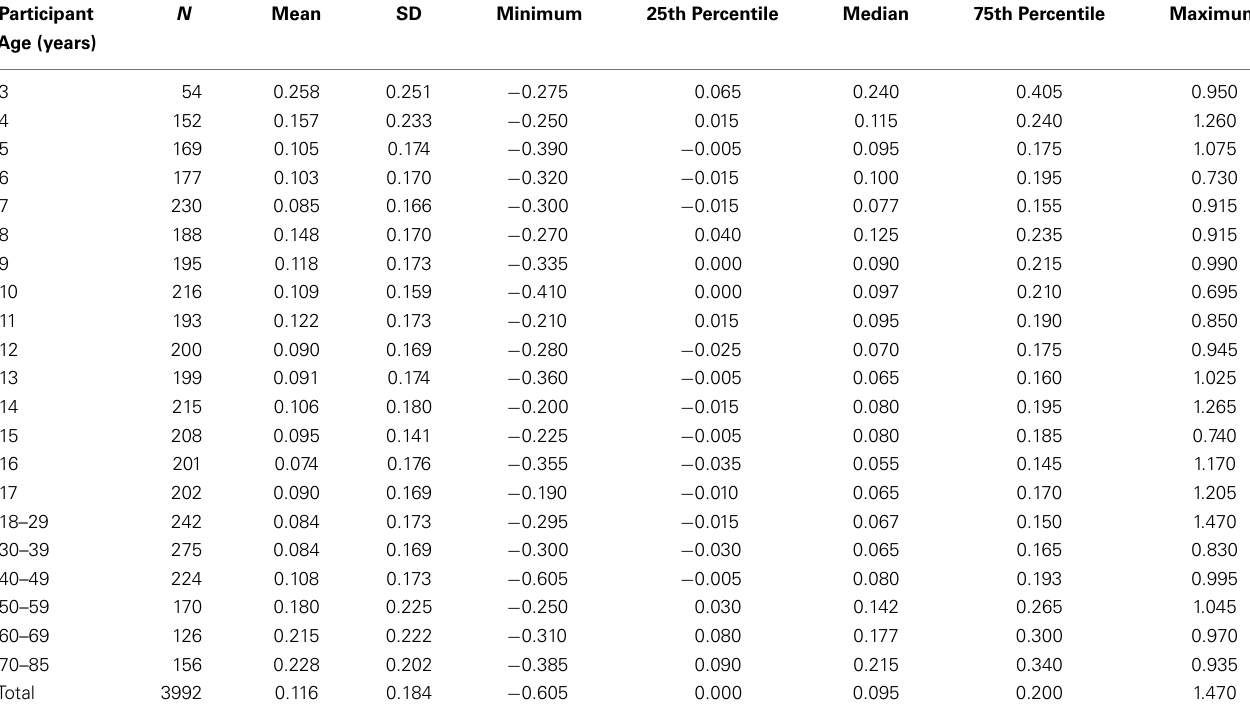
Table 2 | Normative values of the NIHToolbox DVA test by age group